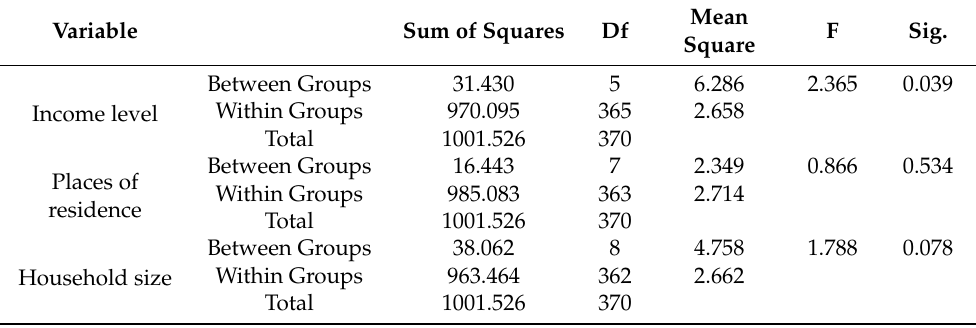
Table 7. Results from ANOVA regarding classes of pharmaceutical wastes and households’ income, household size and places of residence. Df = degree of freedom; F = F value; Sig. = significance ( p